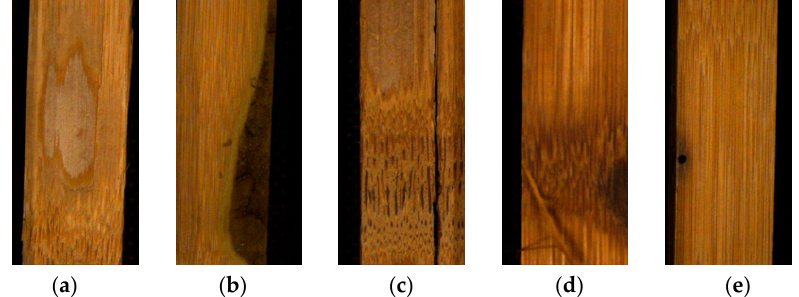
Figure 5. Initial image to 5 divided images (from top to bottom).